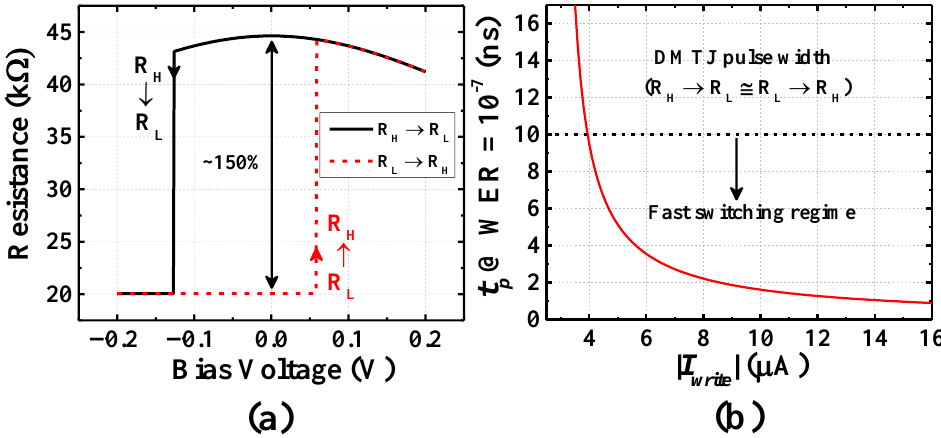
Figure 3. ( a ) DC resistance-voltage characteristic, ( b ) pulse width ( t p ) versus write current ( I write ) for the DMTJ